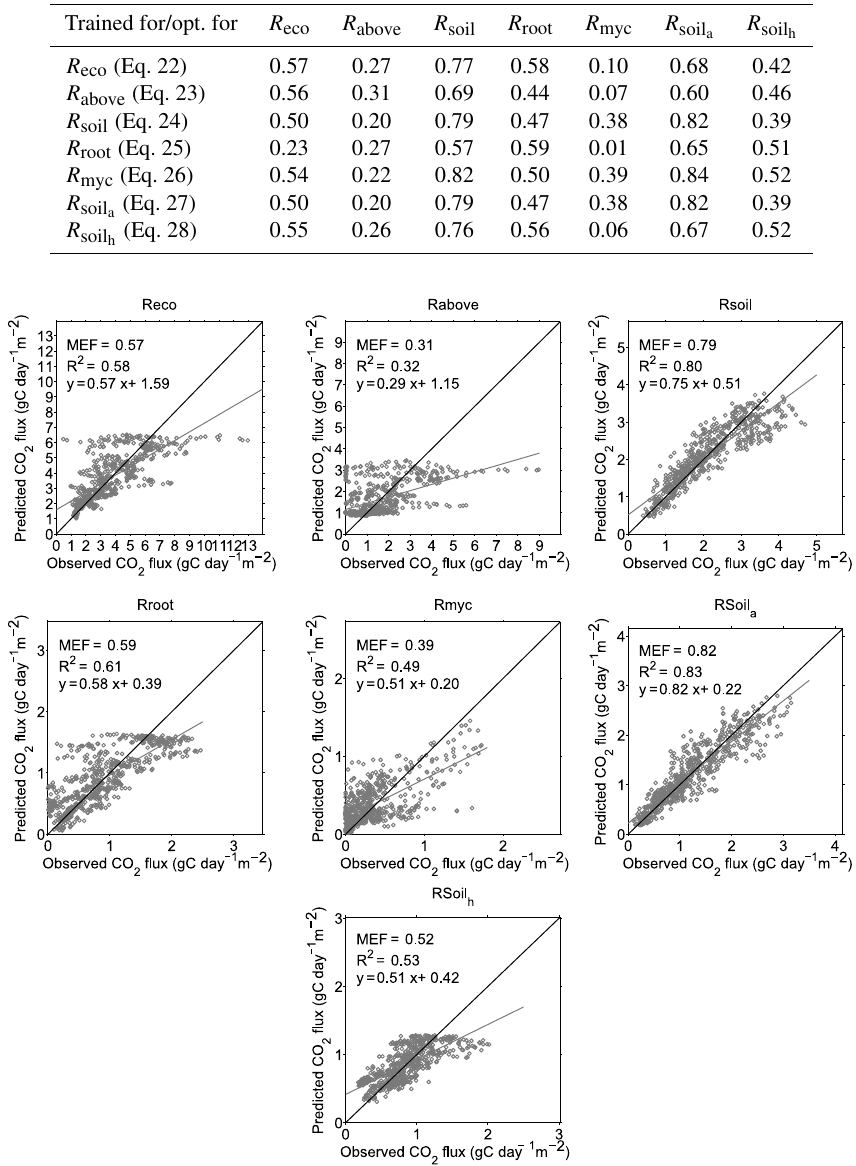
Figure 8. Observed and predicted outgoing CO 2 fluxes; 613 time steps of daily averaged CO 2 effluxes for 2 years at the Alice Holt oak forest site. The predicted values are generated with the models automatically built by the GEP approach with the settings given in Table 1 for the following types of respiration, R eco , R above , R soil , R root , R myc , R soil The models are given in Eqs.